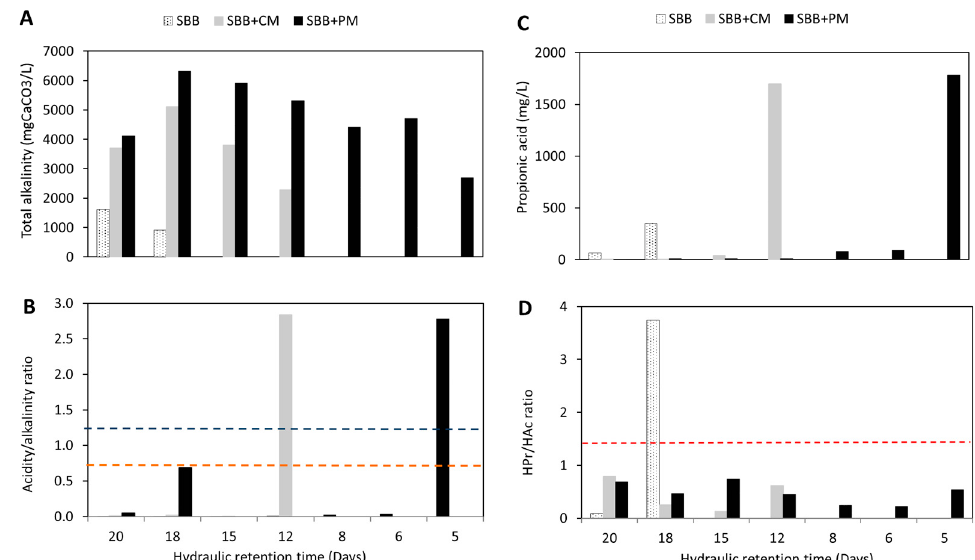
Figure 7. The classical parameters related to the process stability in the three SSTR. ( A ) The total alkalinity, ( B ) the acidity / alkalinity ratio, ( C ) the propionic acid concentrations, and ( D ) the propionic to acetic acid ratio. Values below the blue line refer to suitable values, values above the orange line indicate the critical threshold for proper operation, and values between both lines refer to alarming values that could distort the digesters. The red line refers to the threshold limit for the HPr / HAc ratio, as values above 1.4 were considered as critical for proper operation.